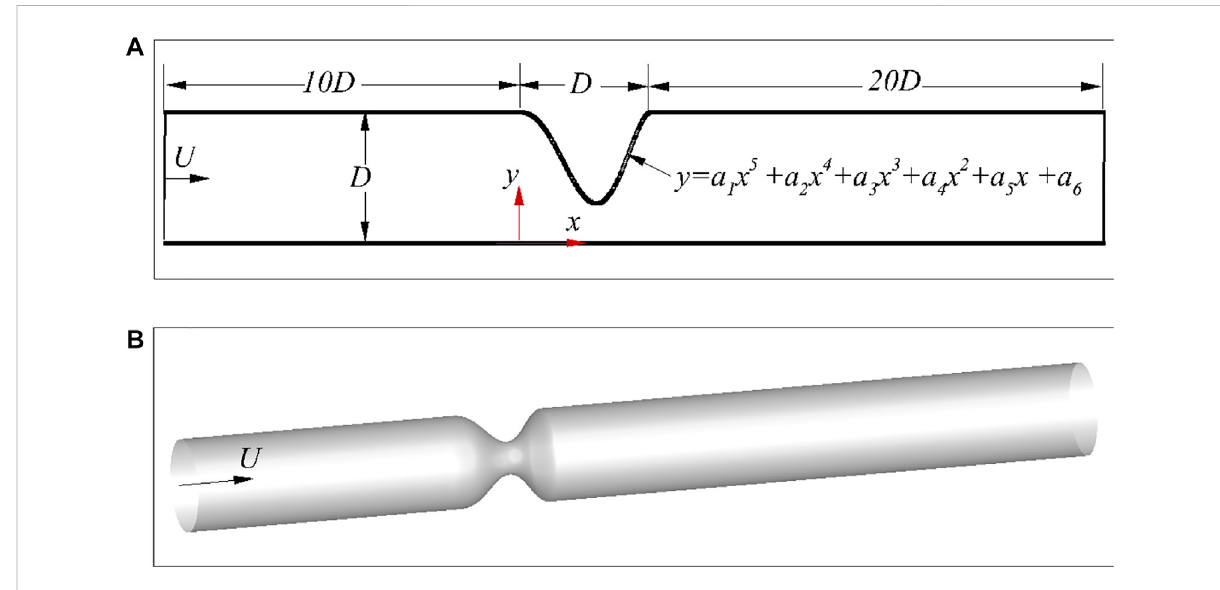
FIGURE 1 Schematic of the stenosed arteries: (A) 2D asymmetric case, and (B) 3D axis-symmetric